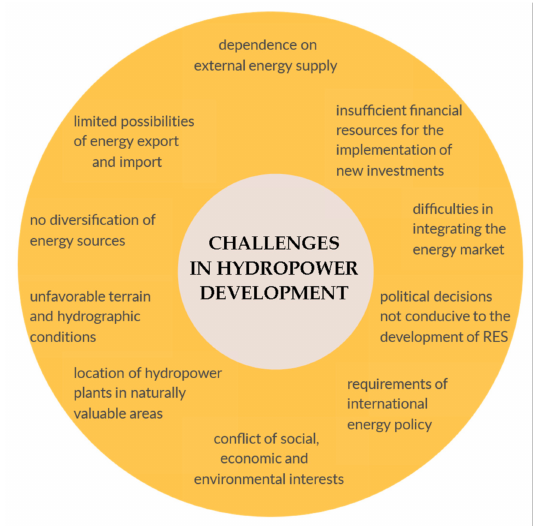
Figure 5. Main challenges facing the development of hydropower resulting from the conducted